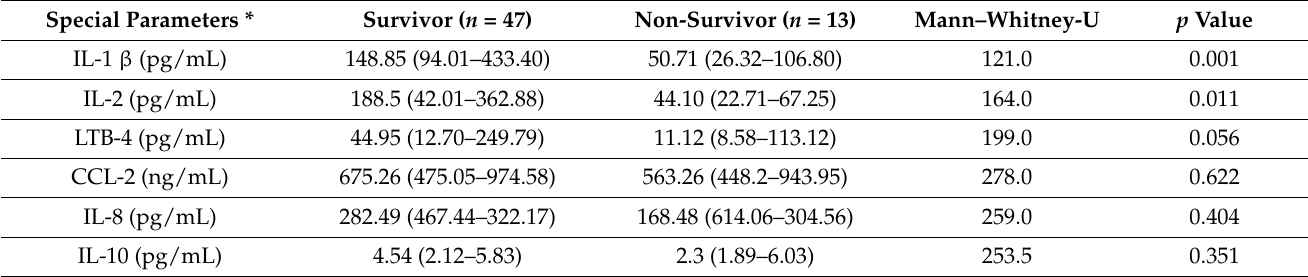
Table 2. Comparison of cytokines and chemokines in the subgroups of the COVID-19 patients.